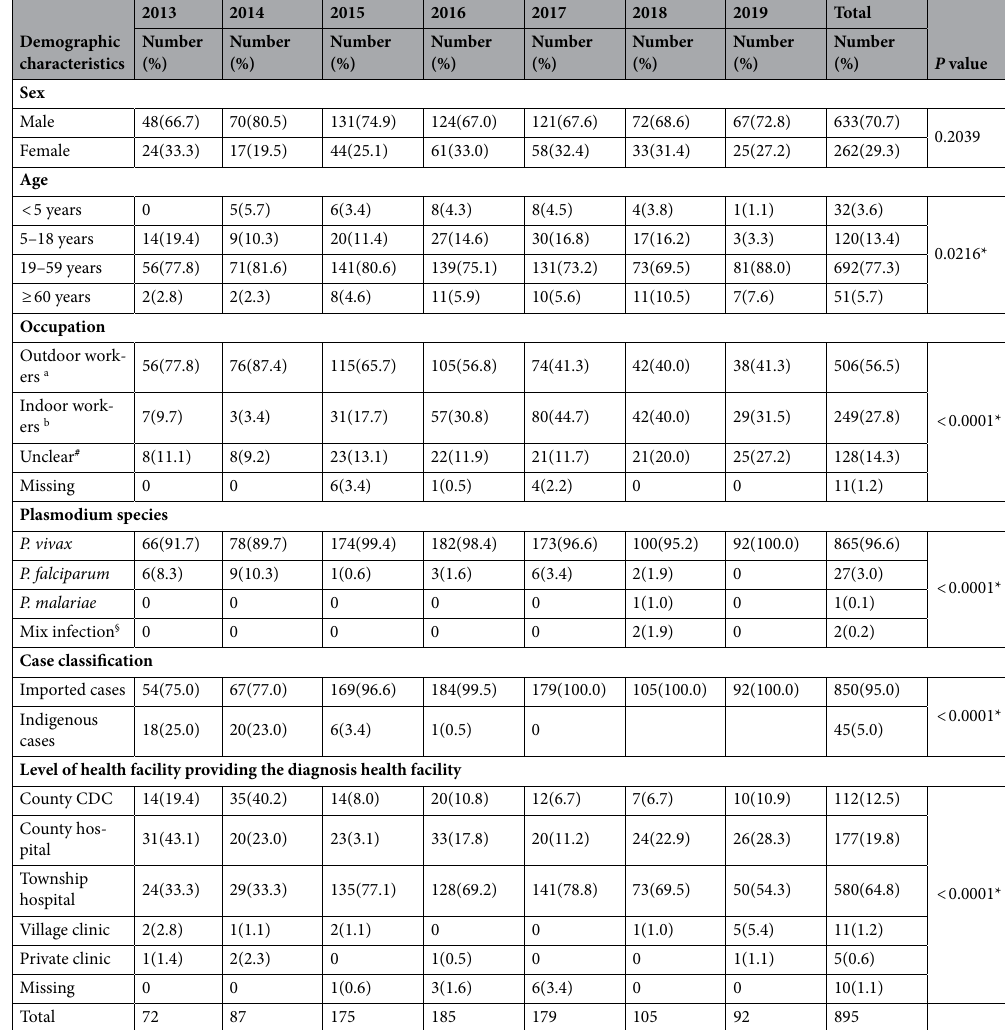
Table 1. Demographic characteristics of the reported malaria cases in Yingjiang County, 2013–2019. a Outdoor workers were persons whose activities were mostly conducted outside and had a high risk of exposure to outdoor biting vectors, especially outdoor night-time workers. This included Architectural engineers, Construction workers, Farmers, Fishermen, Open mine workers, Sailors/Truck drivers,